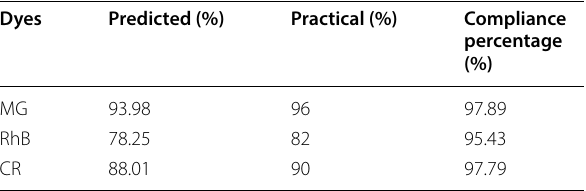
Table 4 Practical and predicted values for dyes removal by using Taguchi method